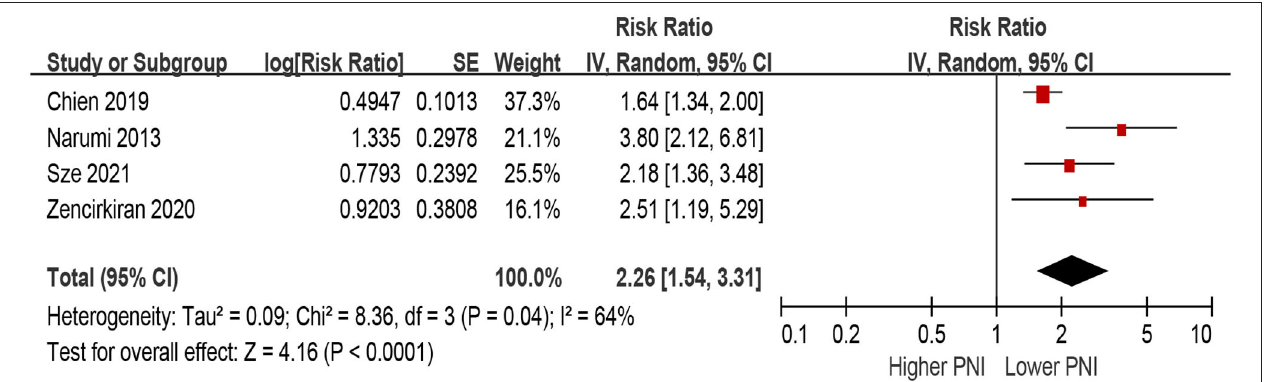
FIGURE 7 | The association between PNI (defined as lower vs. higher) and the risk of MACEs in HF (multivariable-adjusted model). CI, confidence interval; HF, heart failure; MACEs, major adverse cardiac outcomes; PNI, prognostic nutritional